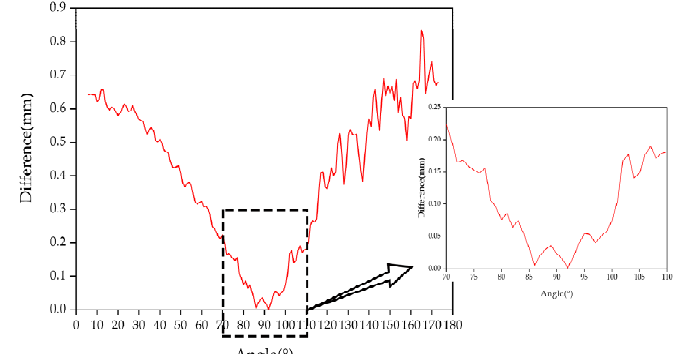
Figure 6. Yaw angle measurement results.